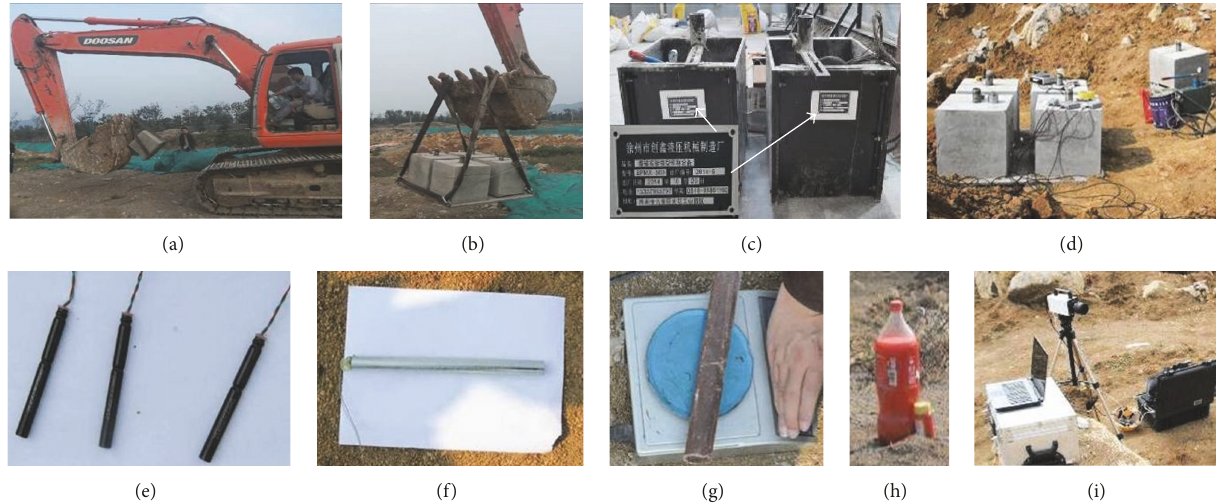
Figure 3: Pressured water coupling blasting test equipment: (a) delivery of a single block; (b) delivery of a few blocks; (c) the mould for making cement blocks; (d) prepared block samples; (e) detonator; (f) home-made cartridge; (g) ammonium nitrate explosive and electronic scale; (h) colored water; (i) high-speed camera.